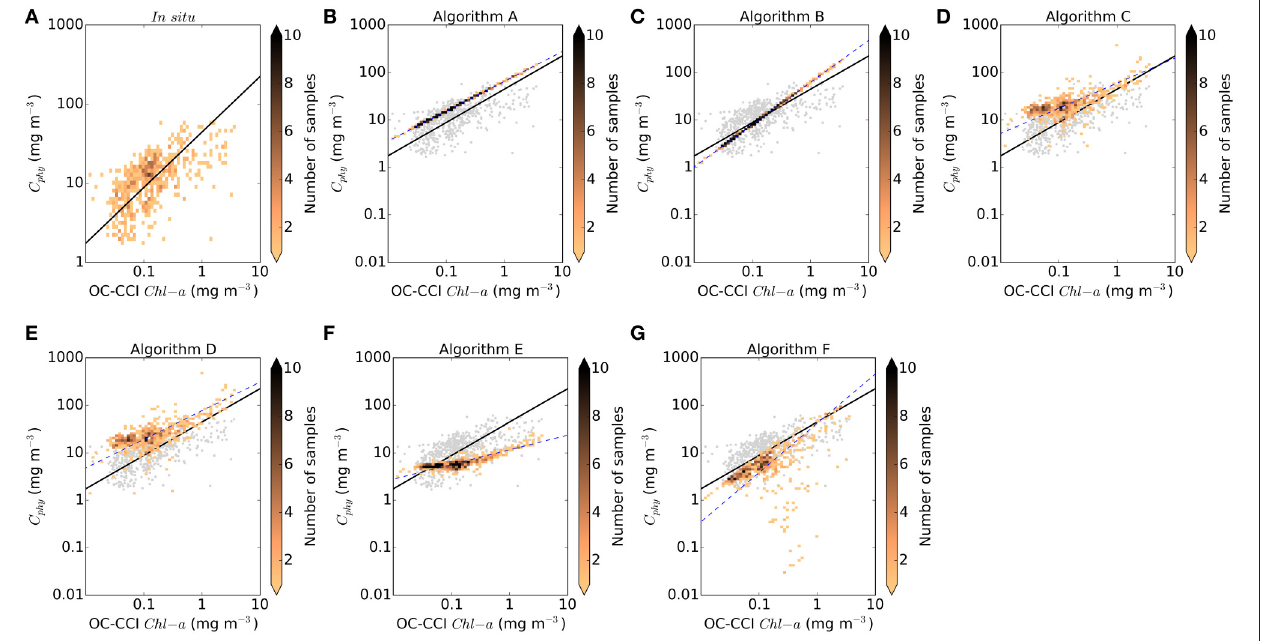
ratio greater than 100 mg C mg Chla − 1 for prymnesiophytes, cyanobacteria and Prochlorococcus sp. Direct observations